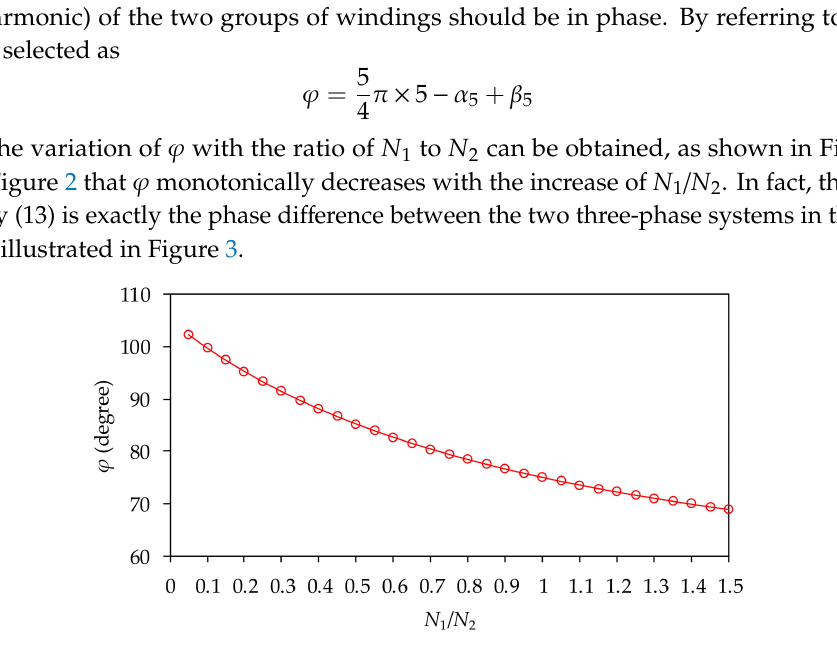
Figure 2. Variation of ϕ with N 1 / N 2